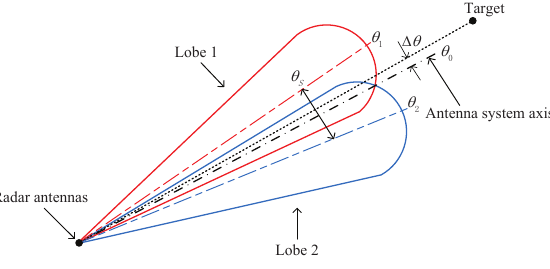
Figure 1. Partial antenna patterns for amplitude comparison monopulse